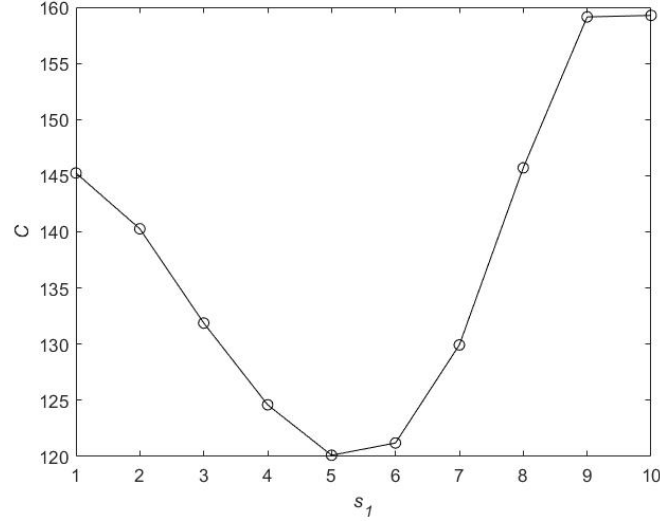
Figure 6. Variation trends of C under different s 1 .